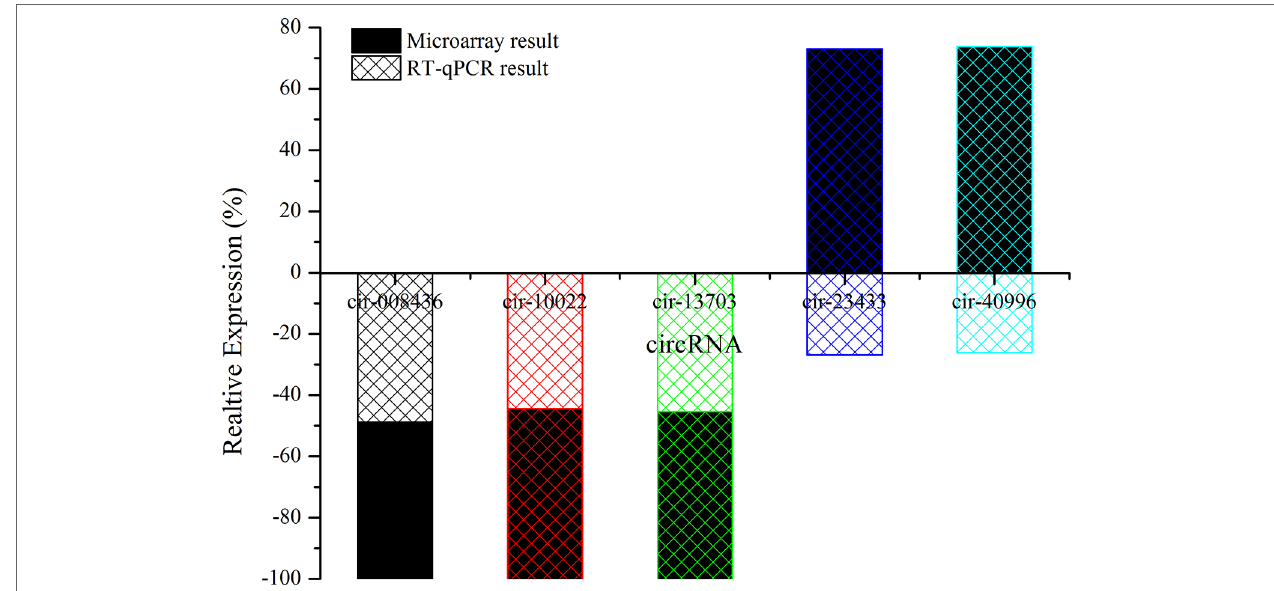
FIGURE 7 | The contrast between qRT-PCR and microarray analysis (n = 3). The vertical axis shows the percentage of each circRNA detected by RT-qPCR and microarray